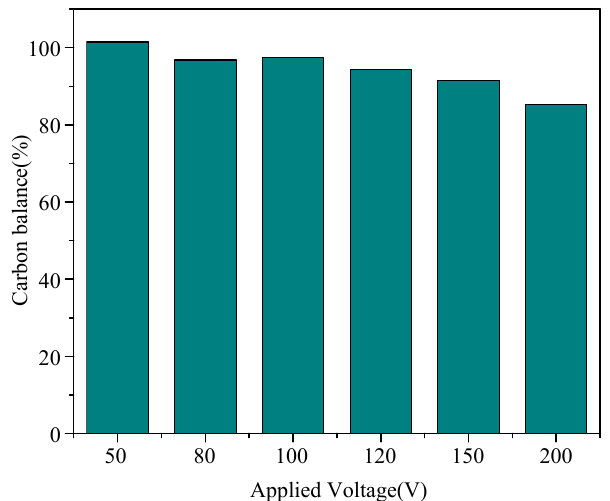
Figure 9. Carbon balance of different applied voltages on the MnTi catalyst.